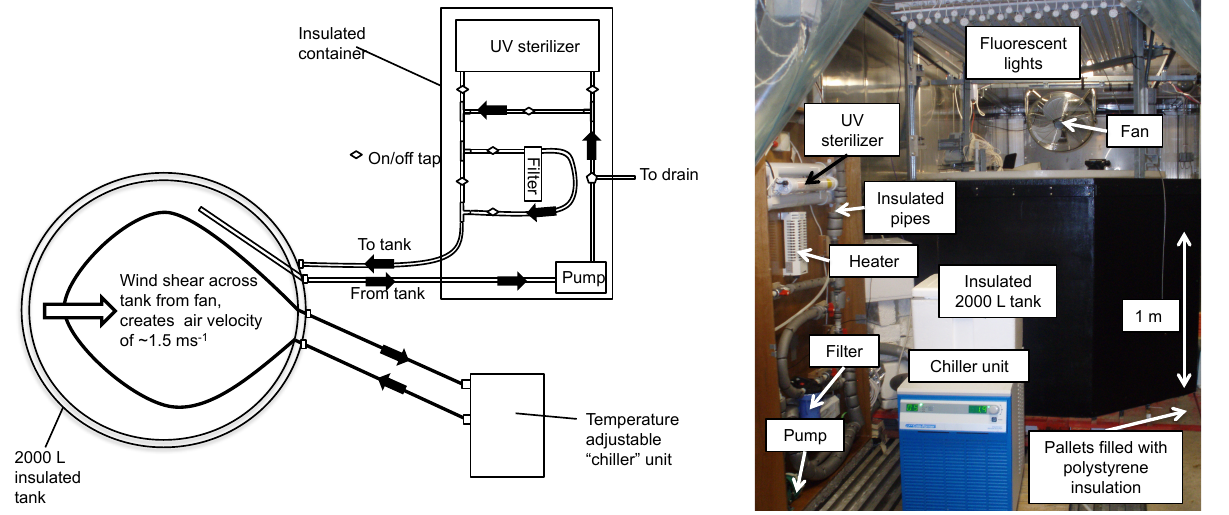
Figure 1. Plan of the sea ice simulator showing the 2000L cylindrical tank (1.32m height × 1.39m diameter) in plan view and water conditioning unit in horizontal view and annotated photo of the facility. A closed pipe runs around the base of the tank connected to a heater unit circulating a water and glycol mixture gently warming the base of the tank. Water is circulated around the tank by a pump in an insulated container and also passed through a UV sterilizer and particulate filter. Note that the diffusing hood and insulation have been stripped away for clarity in the photo.